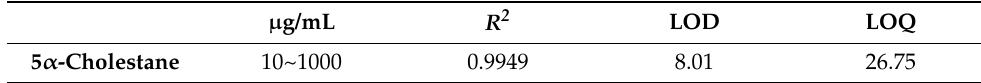
Table 2. Validation parameters of the proposed method. µ g/mL R 2 LOD LOQ 5 α -Cholestane 26.75